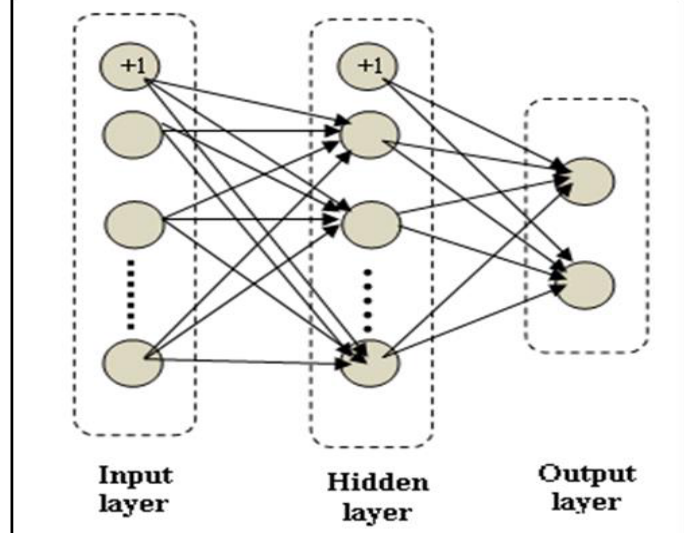
Figure 9. Three-layer neural network with fully connected